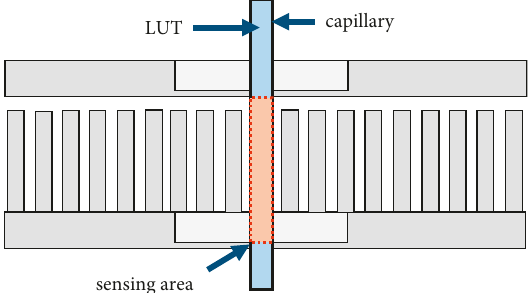
Figure 6: Geometrical diagram of the GWCR with WUT.